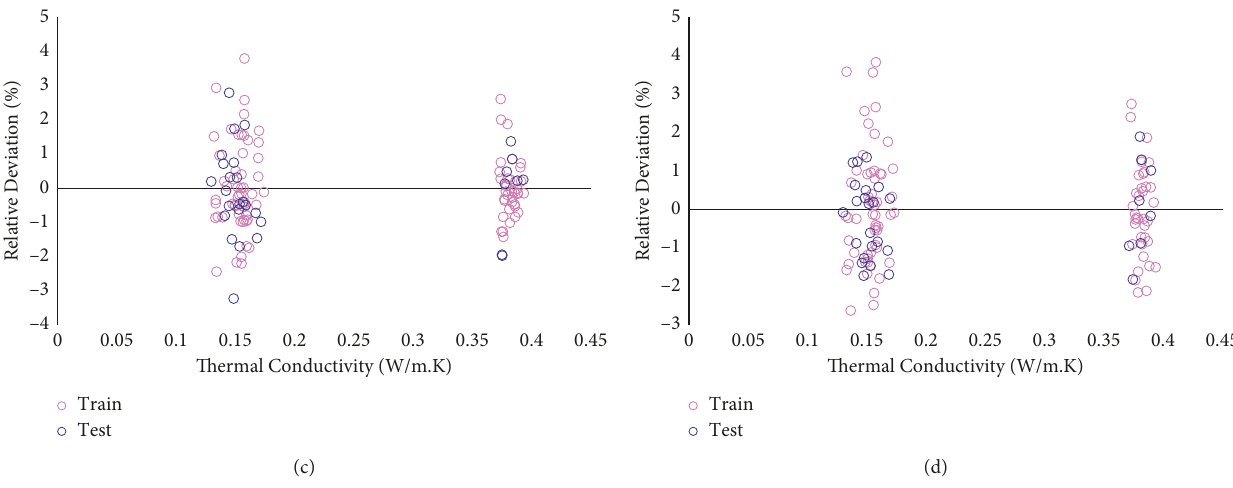
Figure 5: RD analysis to determine the accuracy of different models using various KFs: (a) M, (b) E, (c) SE, and (d)